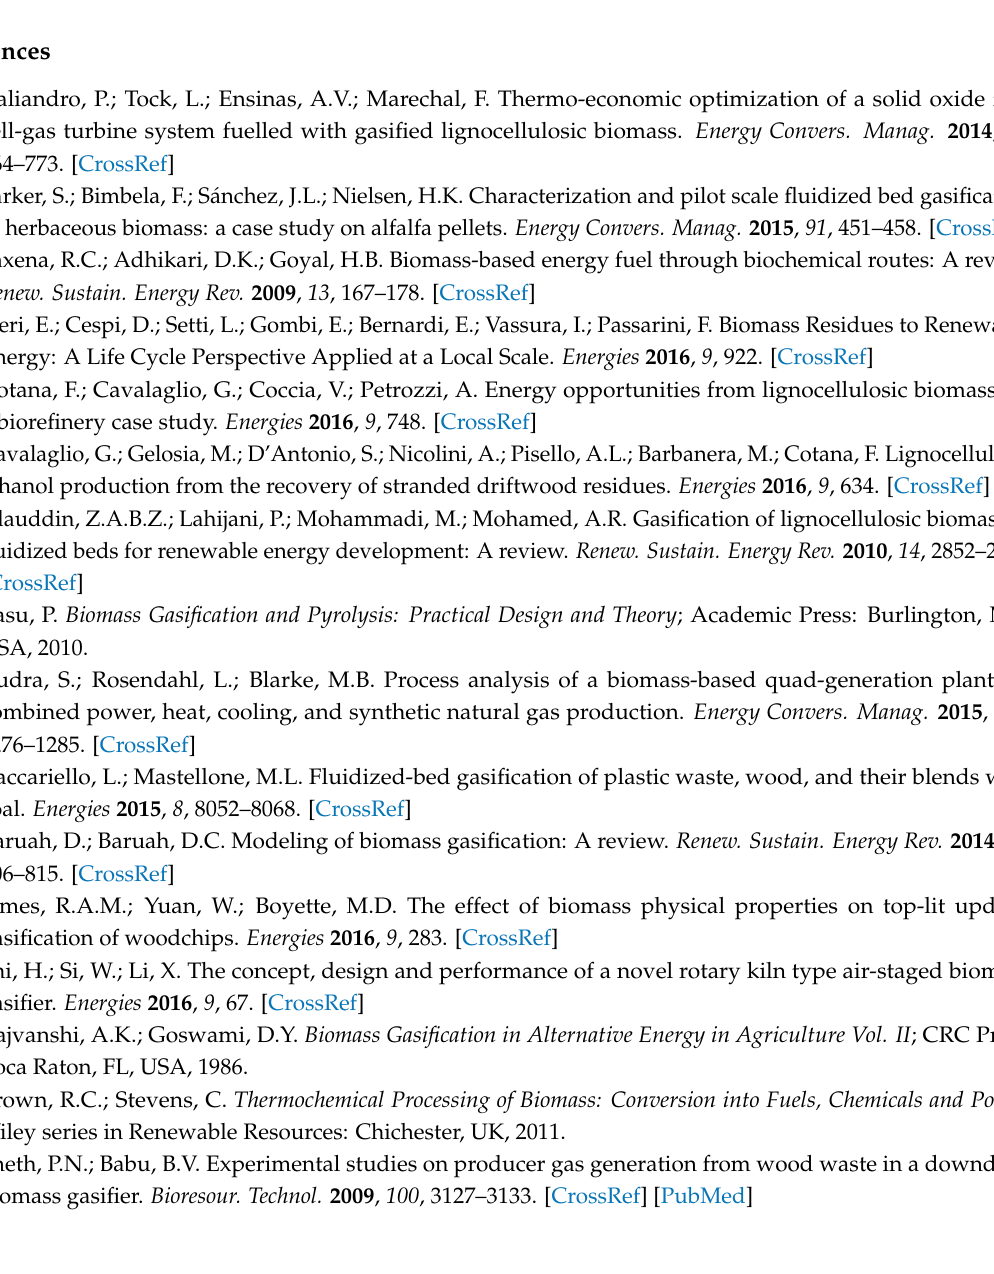
( a ) ( b ) ( c ) Figure A3. CO 2 contours with ER values of ( a ) 0.2; ( b ) 0.35; ( c ) 0.5 from left to right.